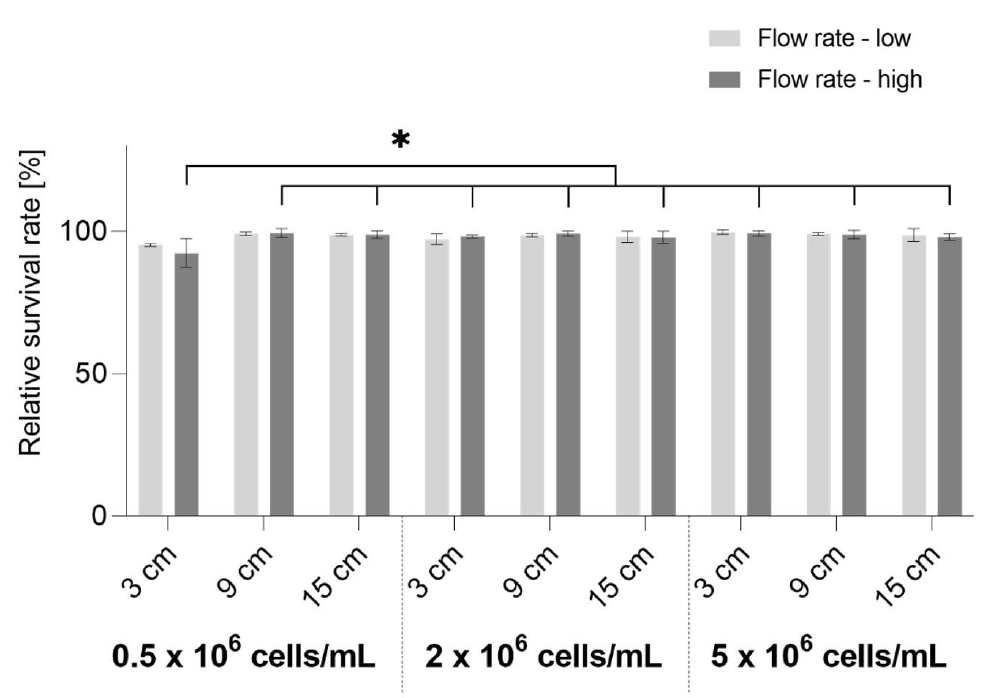
Figure 4. Relative survival rates of sprayed HUVECs ( n = 3) for high or low spraying flow rate, cell concentrations and working distances (3 cm, 9 cm, and 15 cm). Differences with p < 0.05 were considered significant and are marked with